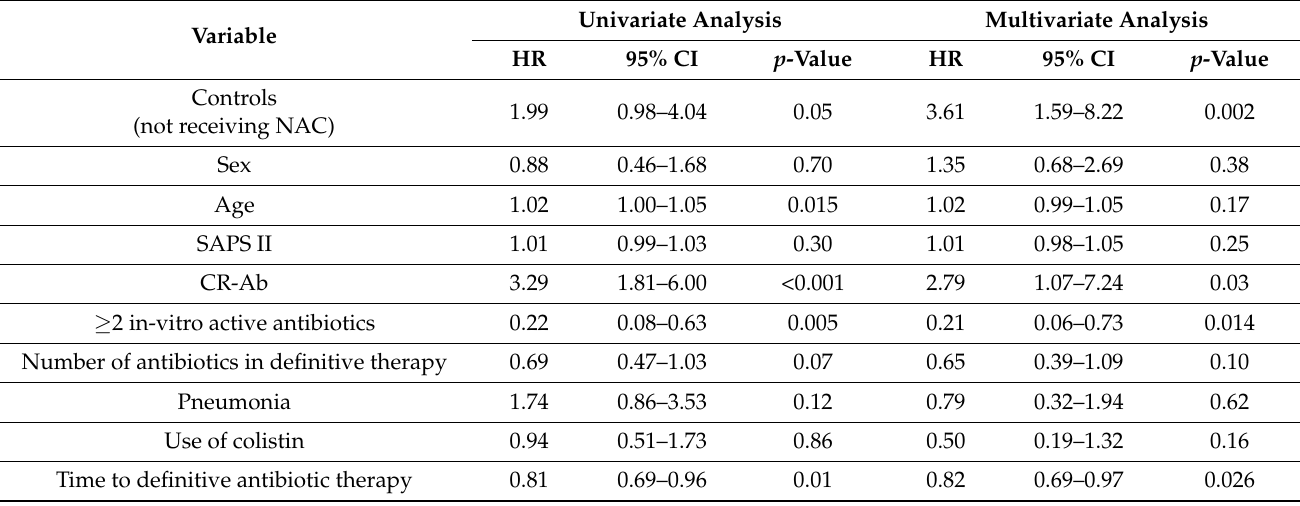
Time to definitive antibiotic